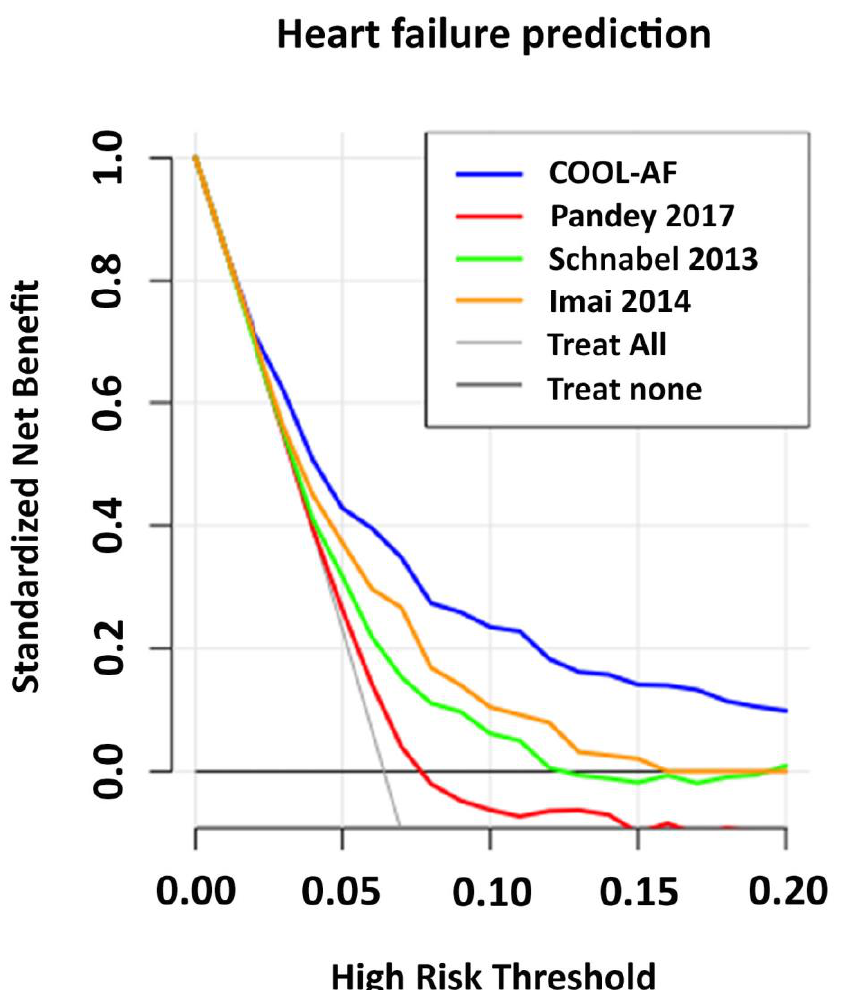
Figure 6. Decision curve analysis (DCA) for the assessment of the ability to make better decisions with a model than without. Each graph represents DCA of each model compared to no models (treat all and treat none). COOL-AF model was compared to Pandey et al. [15], Schnabel et al. [16] and Imai et al. [17].